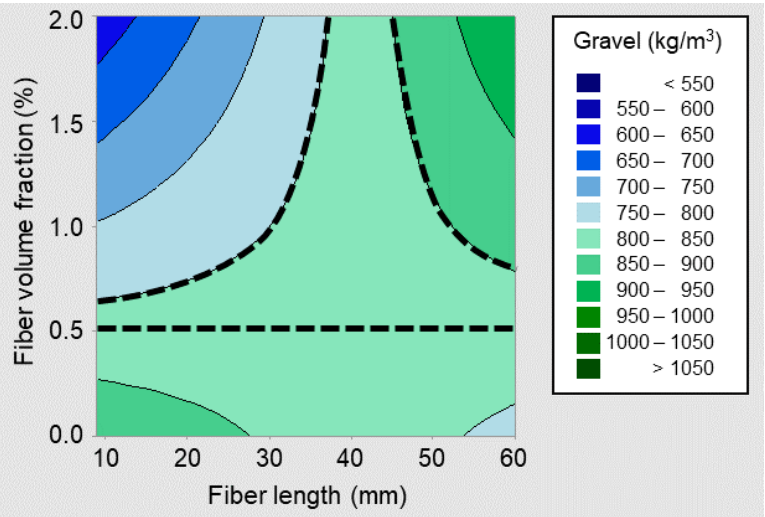
Figure 4. Coarse aggregate content against fiber length and volume fraction.